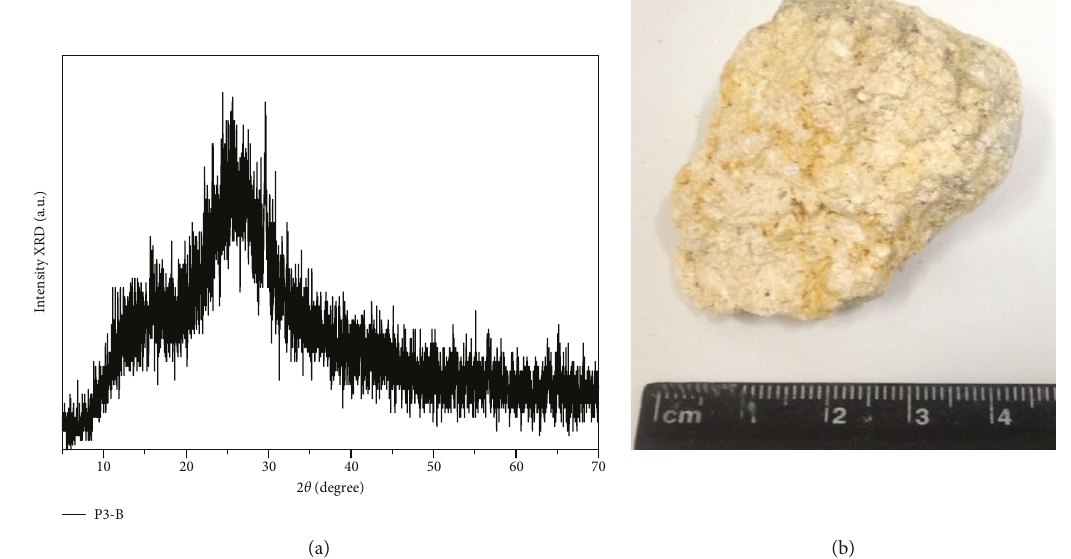
Figure 14: Sample P3-B (a) XRD patterns and (b) rock sample of crystalline tu ff